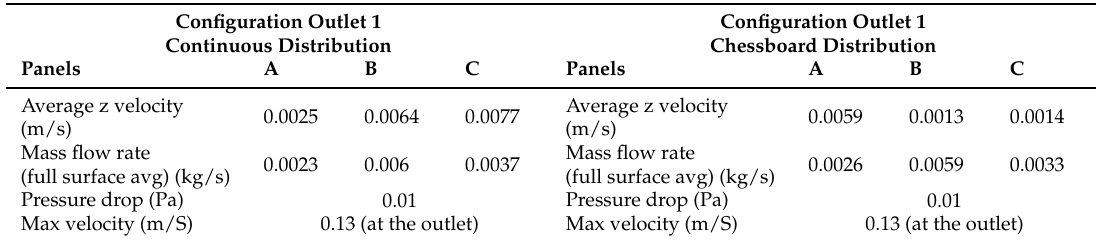
Table 3. Calculated quantities in the continuous and chessboard distributions for Outlet Configuration 1.